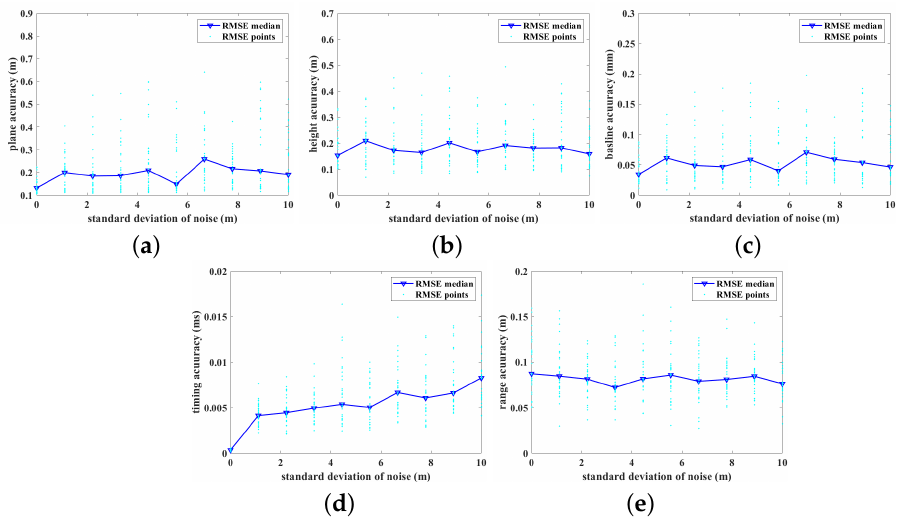
Figure 8. RMSEs of parameters after adjustment in the simulated experiment for noise. ( a , b ) are the horizontal and vertical adjustment accuracies, respectively. ( c – e ) are the RMSEs of parallel baseline, slant range, and timing parameters, respectively. The data points are the results of all experiments, and the lines are median change curves of RMSEs of each group of experiments.